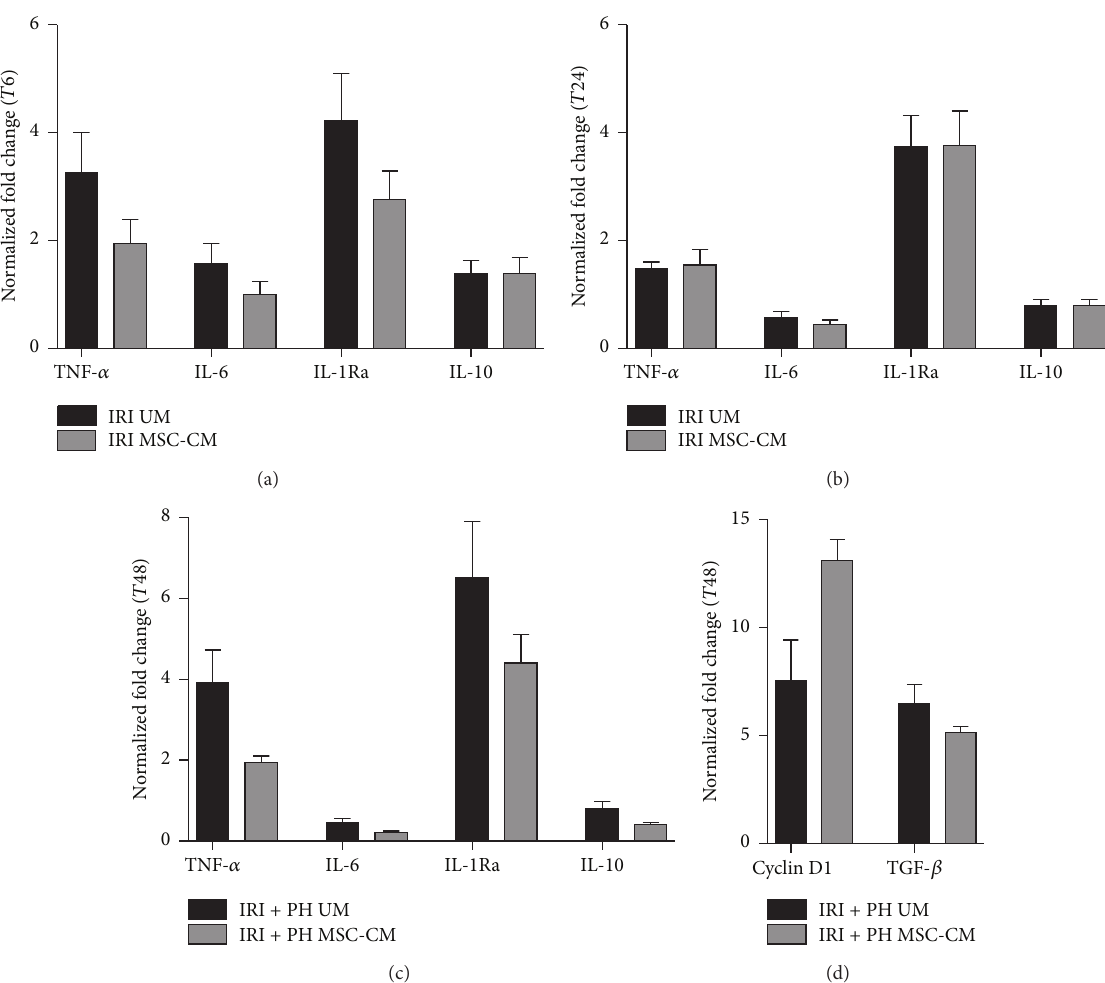
Figure 5: Effects of MSC-CM on hepatic gene expression. Hepatic gene expression levels were determined by quantitative RT-PCR and normalized against TBP. Expression levels of inflammation related genes at (a) 6 hours after IRI, (b) 24 hours after IRI, and (c) 48 hours after IRI + PH; (d) expression levels of cell cycle related genes at 48 hours after IRI +